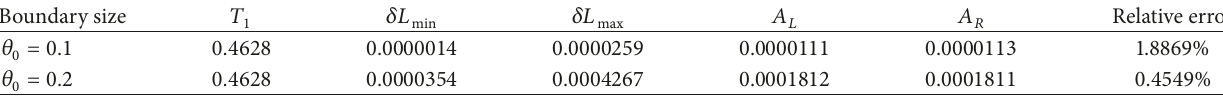
Table 2: EAL in the 𝑇 - 𝛿𝐿 plane; here relative error = (𝐴 𝐿 − 𝐴 𝑅 )/𝐴 𝑅 . Boundary size 𝑇 1 𝛿𝐿 min 𝛿𝐿 max 𝐴 𝐿 𝐴 𝑅 Relative error 𝜃 = 0.1 0.4628 0.0000014 0.0000259 0.0000111 0.0000113 1.8869% 0 𝜃 = 0.2 0.4628 0.0000354 0.0004267 0.0001812 0.0001811 0